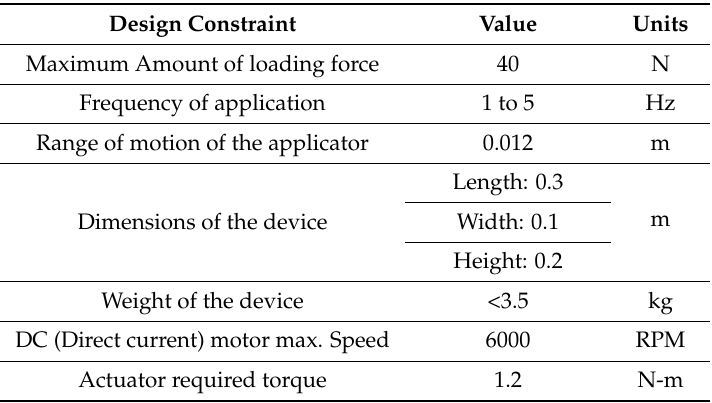
Table 1. List of design constraints for the proposed